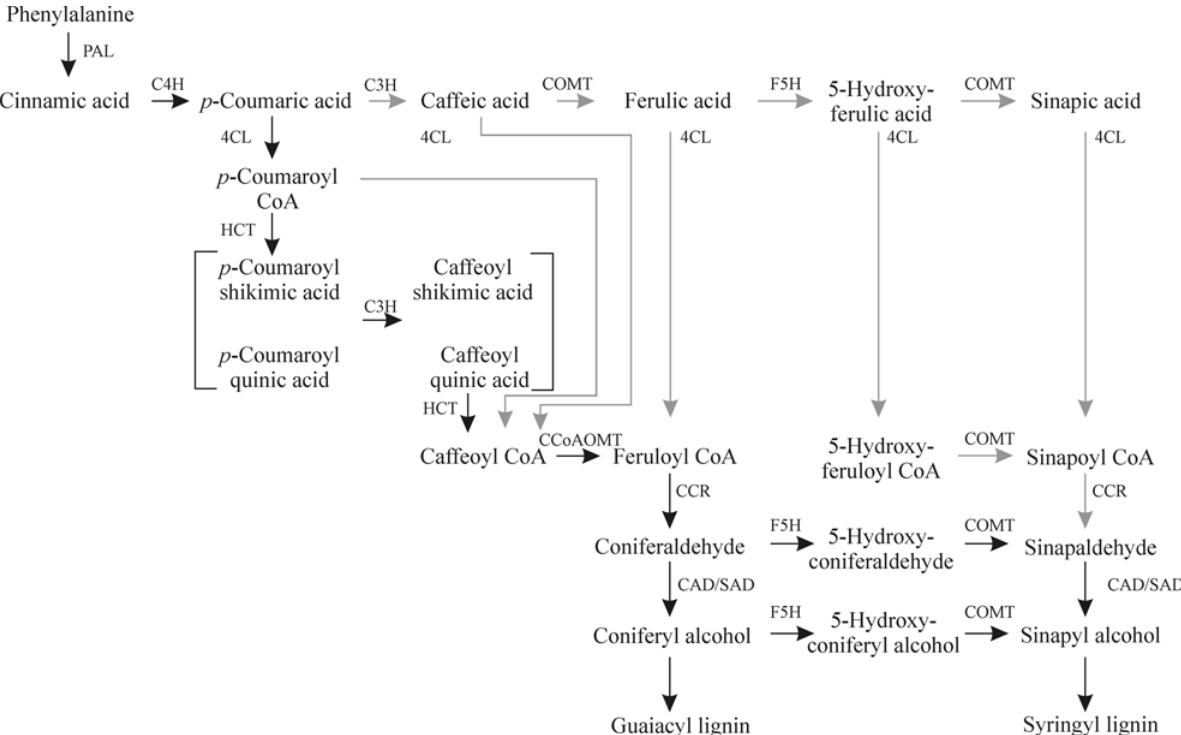
Figure 1 - Phenylpropanoid pathway leading to monolignol precursors of lignin. Black arrows indicate the current revised pathway, gray arrows indicate previous interpretation of the pathway (adapted from Humphreys and Chapple, 2002). 4CL, 4-hydroxycinnamoyl CoA ligase; C3H, p -coumarate 3-hydroxylase; C4H, cinnamate 4-hydroxylase; CAD, cinnamyl alcohol dehydrogenase; CCoAOMT, caffeoyl CoA O -methyltransferase; CCR, cinnamoyl CoA reductase; COMT, caffeic acid O -methyltransferase; F5H, ferulate 5-hydroxylase; HCT, hydroxycinnamoyl-CoA:shikimate/quinate hydroxycinnamoyltransferase; PAL, phenylalanine ammonia-lyase; SAD, sinapyl alcohol